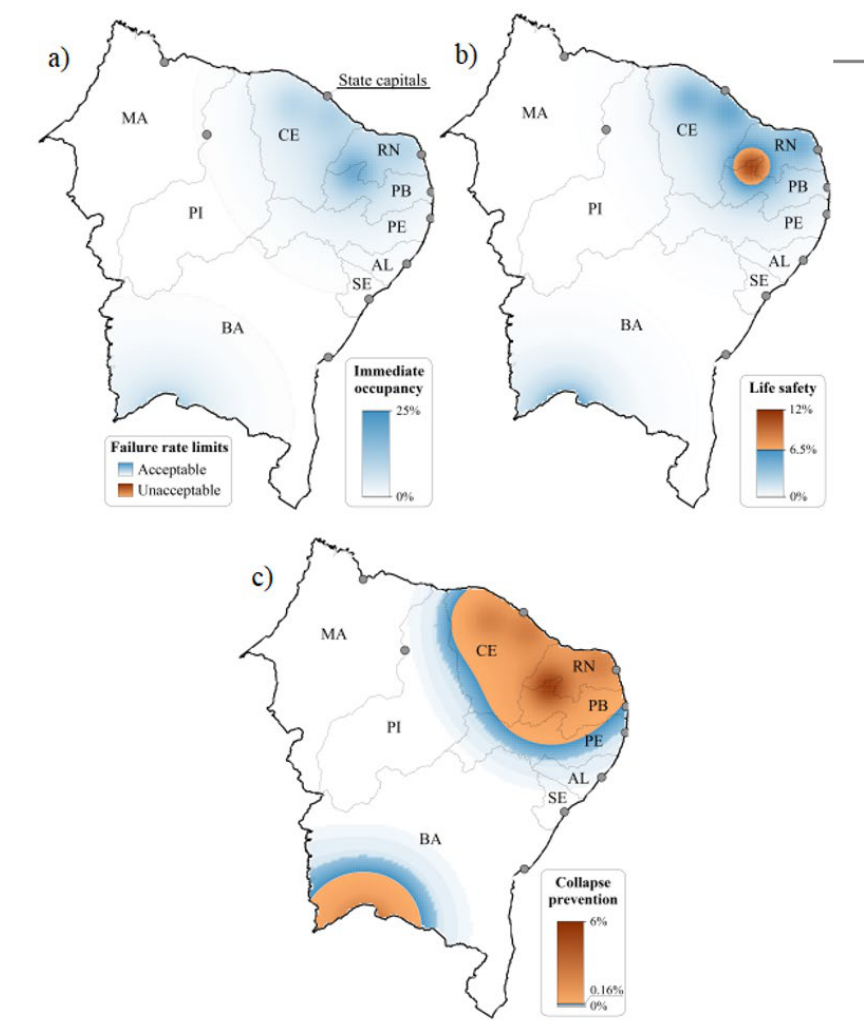
Figure 7. Failure probability maps considering a 50-year period: a) Immediate Occupancy; b) Life Safety; c) Collapse